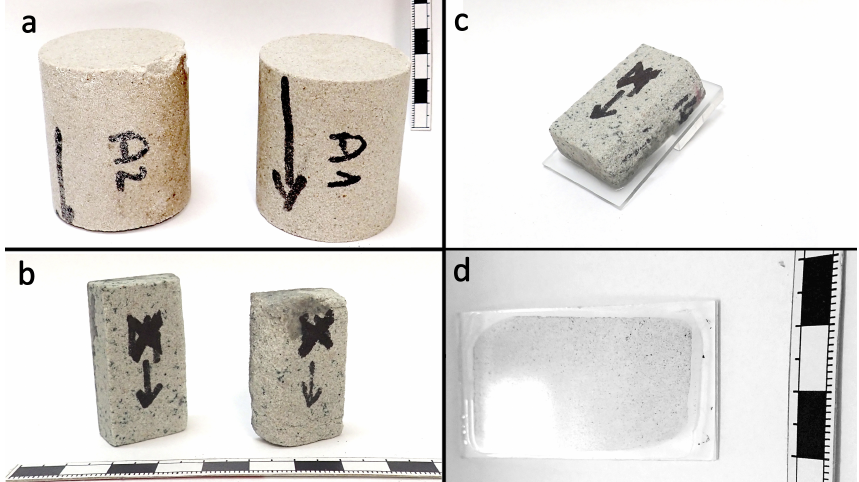
Figure 2. Steps in preparation of rock (sandstone) thin section. ( a ) Samples of a drill core, ( b ) cuboid- shaped chips of rock, ( c ) smaller slice of rock in a cuboid shape mounted in a glass-slide, ( d ) final sandstone thin